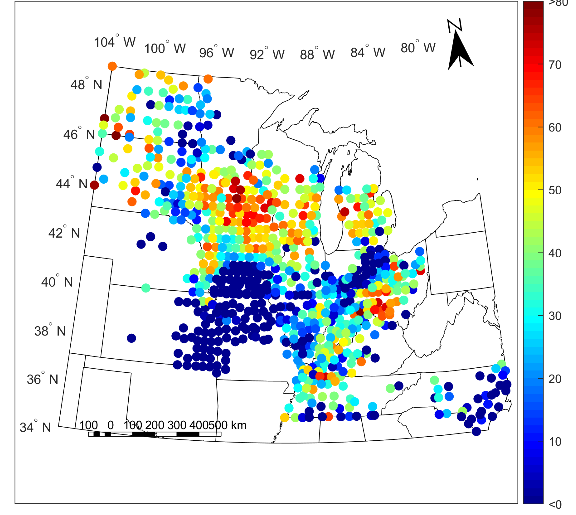
Figure 6. LOO yield prediction ESTD values (%) averaged for each county for the 20-cluster weather-based clustering calibration.